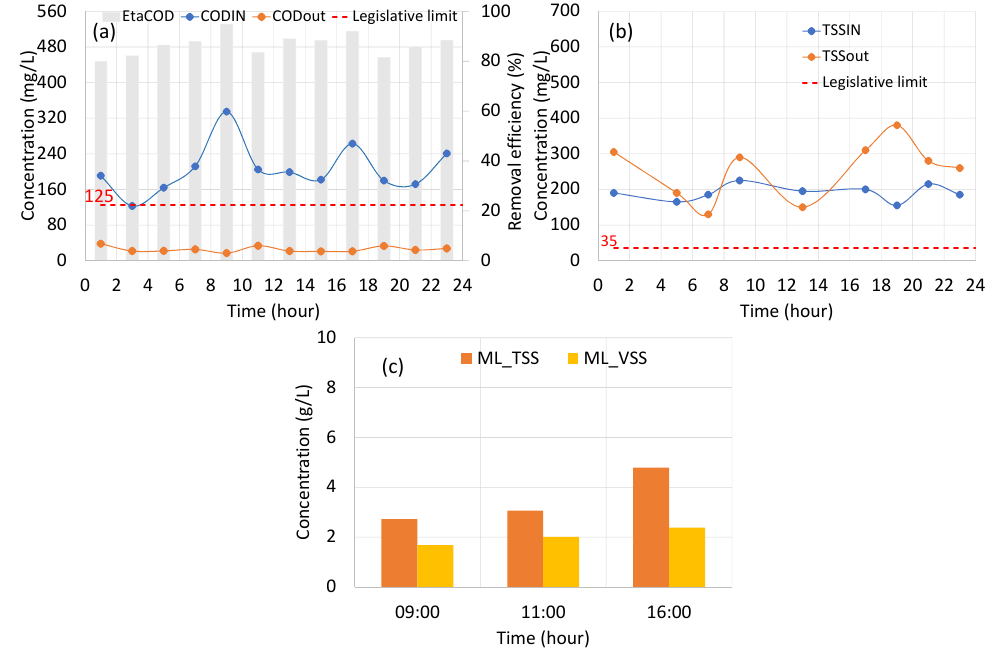
Figure 10. The trend of influent (IN, Section 1) and effluent (out, Section 3) measured the COD, removal efficiency (EtaCOD) and legislative limit ( a ); the trend of influent (IN) and effluent (out) measured the TSS and legislative limit ( b ) and measured the mixed liquor (Section 2) TSS (ML_TSS) and VSS (ML_VSS) ( c ) Corleone WWTP .